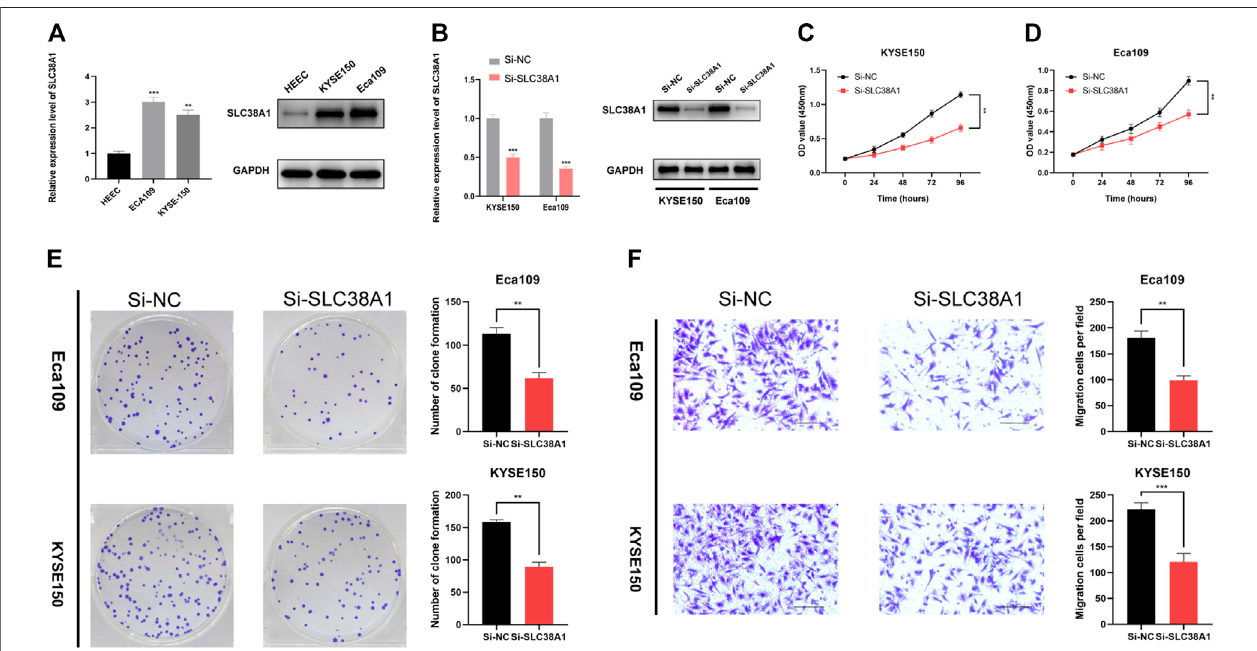
FIGURE9| EffectsofinhibitingtheexpressionofSLC38A1onESCCcellproliferationandmigration. (A) SLC38A1wasupregulatedwithinKYSE-150andEca109cellsrelativeto HEECsbytheqRT-PCRassayandwesternblotanalysis. (B) TheexpressionofSLC38A1wasdownregulatedinKYSE-150andEca109cellsbysiRNAs. (C – E) KYSE-150andEca109 cellproliferationafteranti-SLC38A1siRNAtransfectionwasmeasuredusingCCK-8assays (C,D) andcolonyformationassays (E) . (F) TranswellassaysforESCCcellmigration(scale bars: 100 μ